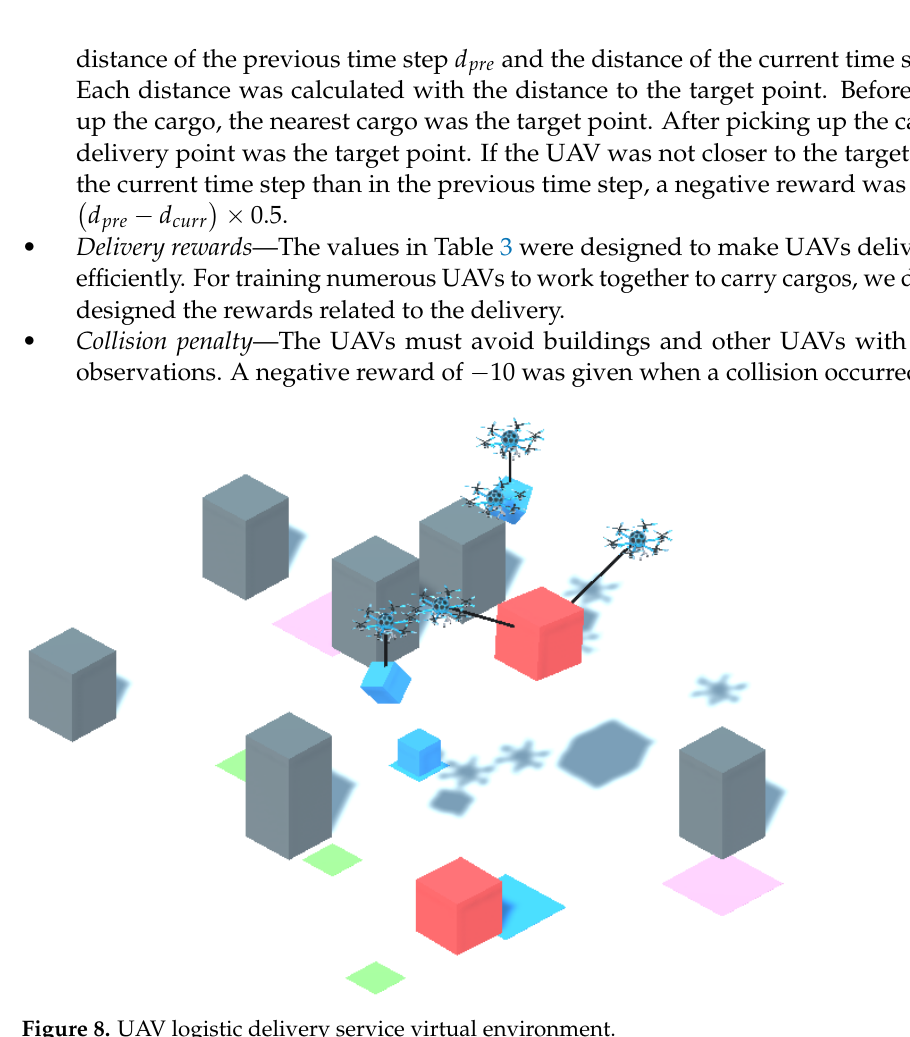
Figure 8. UAV logistic delivery service virtual environment. Table 2. Summary of